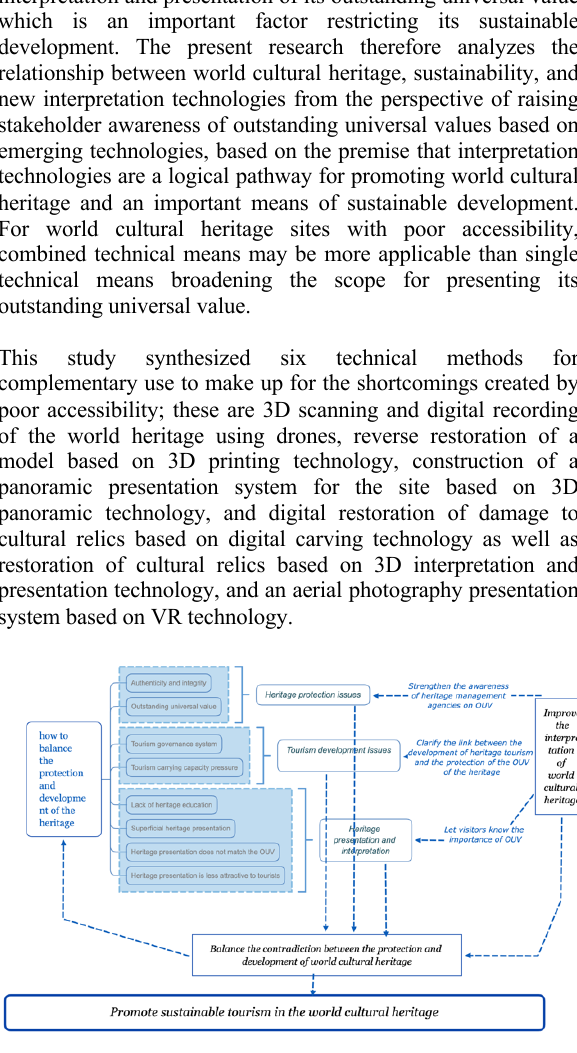
Figure 5 . The logical relationship between sustainable tourism and interpretation based on emerging interpretation technologies.